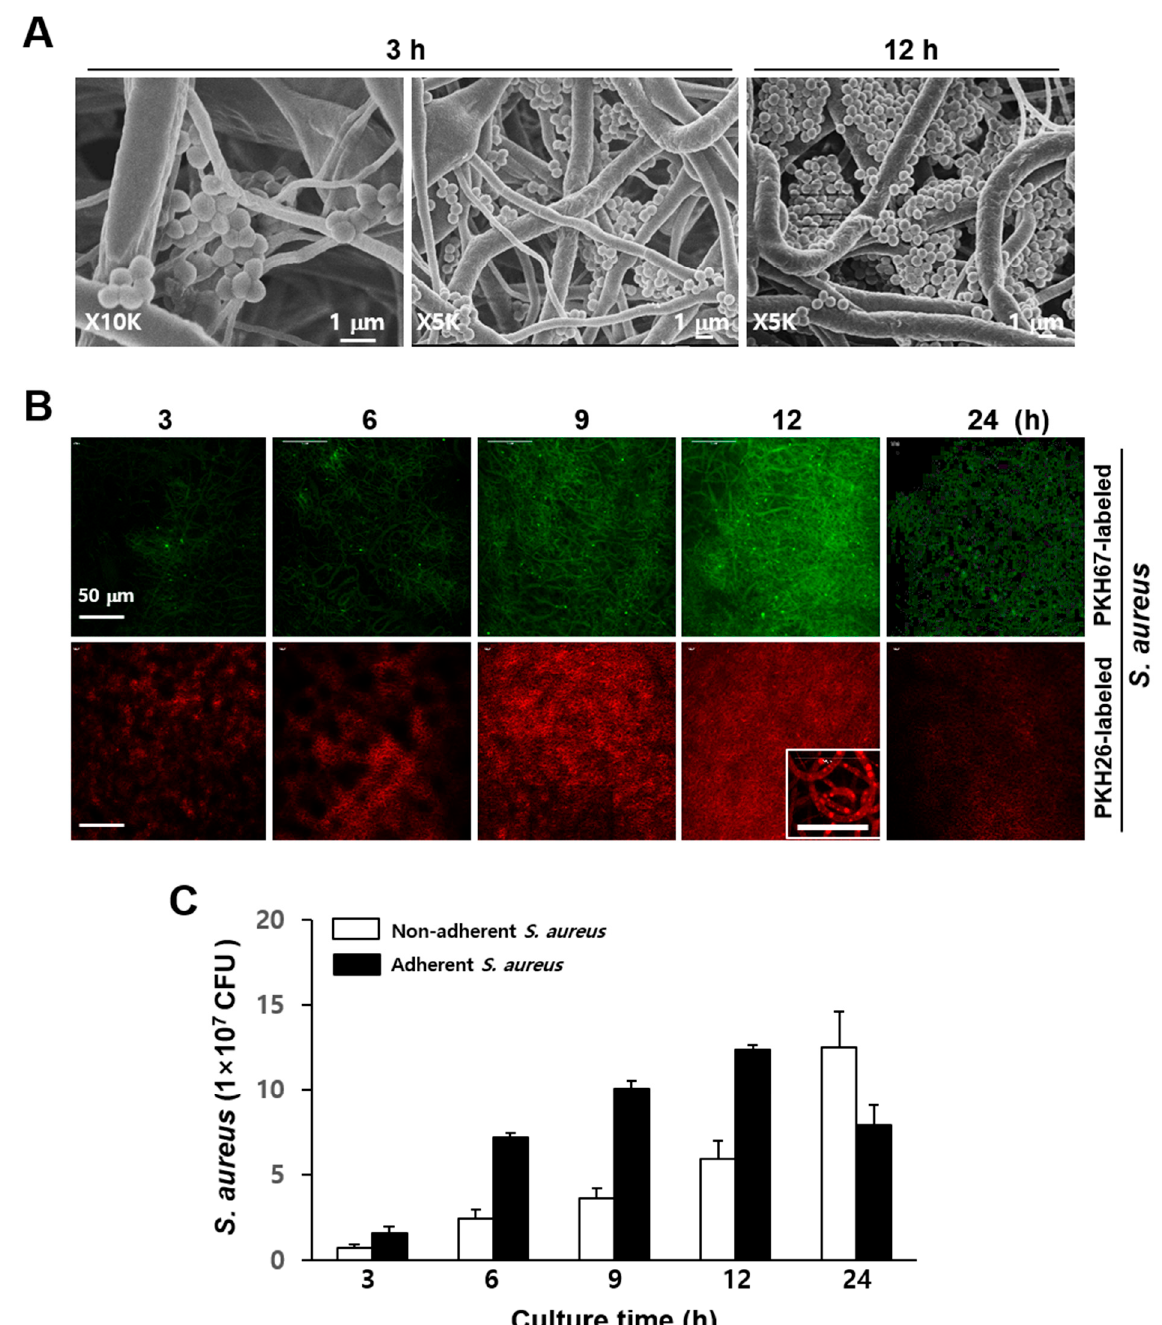
Figure 1. Adhesion of S. aureus to the PCL-NM. ( A ) S. aureus (1 × 10 7 CFU) were top-seeded on the PCL-NM for the indicated times and adhesion of S. aureus to the nanofibers was evaluated by SEM. Images are representative of three independent experiments. ( B ) PKH67- and PKH26-labeled S. aureus (1 × 10 7 CFU) were top-seeded on the PCL-NM and cultured for the indicated times ( n = 3). The adhesion and proliferation of fluorescence-labeled S. aureus in the PCL-NM were evaluated by confocal microscopy. High magnification image ( × 1000) in the box shows numerous spots along the nanofibers. ( C ) S. aureus (1 × 10 7 CFU/200 µ L) were cultured in the PCL-NM for the indicated times. Non-adherent bacteria were gently recovered from culture media (50 µ L) and adherent bacteria on nanofibers were harvested by vigorous pipetting after the addition of culture media (100 µ L) to the PCL-NM. The numbers of non-adherent and adherent bacteria in the PCL-NM were estimated by determining CFUs. Data are presented as means ± SDs ( n =